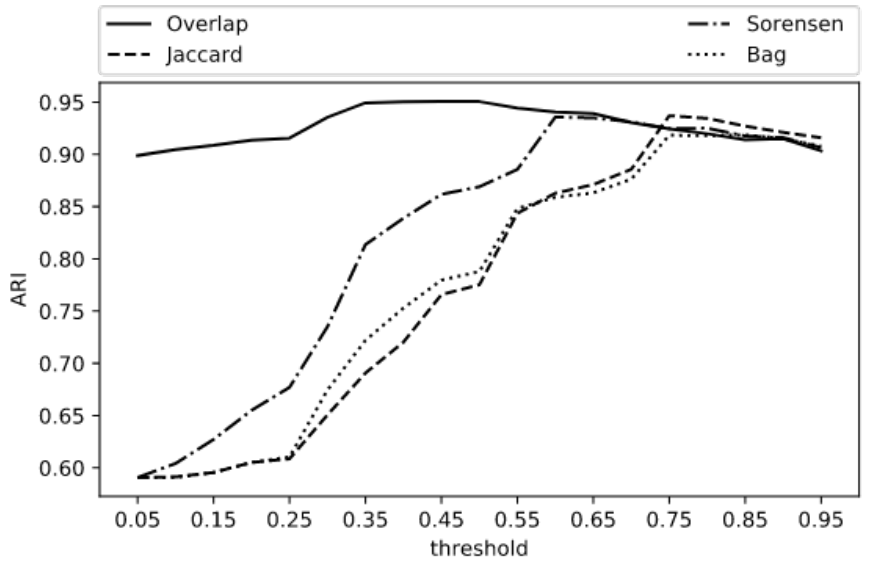
Figure 6. ARI for Overlap, Jaccard, Sorensen and Bag by threshold